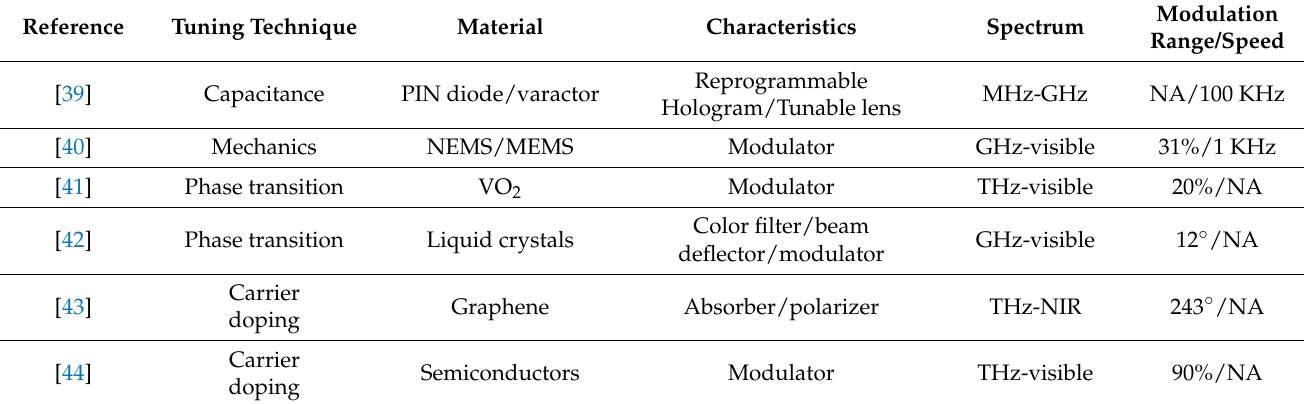
Table 3. Different techniques to realize reconfigurable